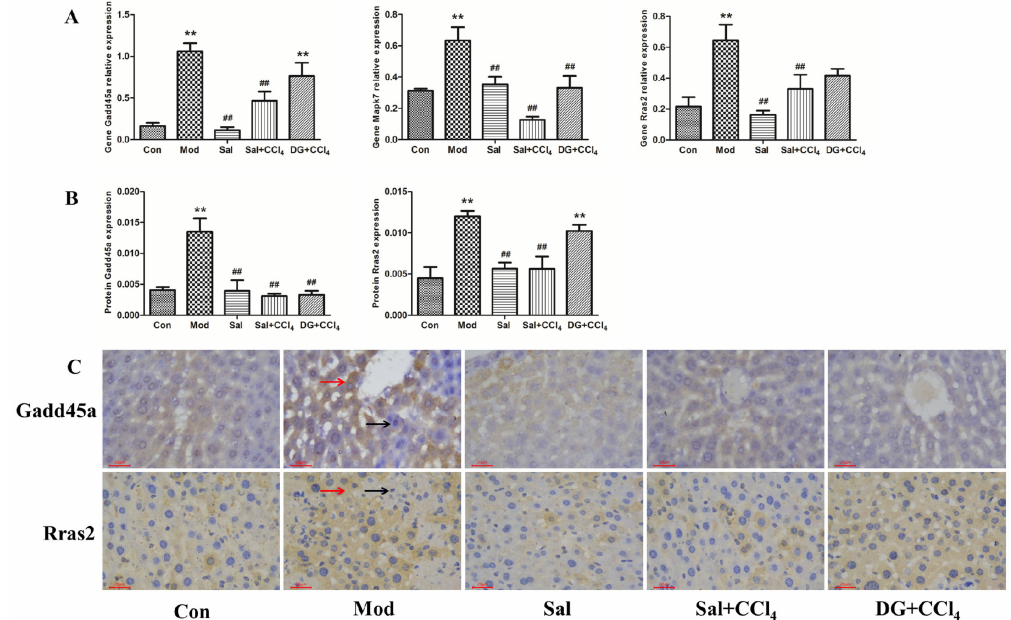
Figure 6. Salidroside protected against carbon tetrachloride (CCl 4 )-induced liver injury by downregulating oxidative stress-related gene Gadd45a, Mapk7, and Rras2. ( A ) Relative expression levels of Gadd45a, Mapk7, and Rras2 genes in di ff erent groups, that is, model mice induced by CCl 4 , and mice treated with single salidroside, salidroside + CCl 4 , and diammonium glycyrrhizinate + CCl 4 (Con, Mod, Sal, Sal + CCl 4 , and DG + CCl 4 groups, respectively). p < 0.05 was considered to be statistically significant. ** p < 0.05 (groups compared with the Con group) and ## p < 0.05 (groups compared with the Mod group). ( B ) Optical density statistics of Gadd45a and Rras2 proteins expression levels in di ff erent groups. ( C ) Immunohistochemical staining of Gadd45a and Rras2 proteins in di ff erent groups. Gadd45a was expressed and distributed in the cytoplasm surrounding the centrilobular veins of the liver in the CCl 4 group and seldom expressed in other groups. Rras2 protein was highly expressed in a sheet in CCl 4 and DG + CCl 4 groups and partially expressed in the hepatocyte of other groups. Brown-yellow or brown substances expressed in the cytoplasm were positive proteins (red arrows). Cell nucleus was stained blue (black arrows). Magnification: 200 × . (Gadd45a: growth arrest and DNA damage-inducible 45 α ; Mapk7: mitogen-activated protein kinase 7; Rras2: related RAS viral oncogene homolog